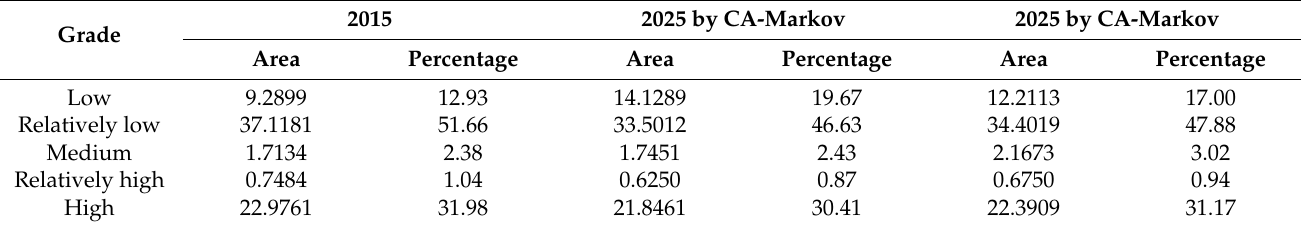
Figure 9. Spatial distribution patterns of habitat quality in 2025 projected by CA-Markov and FLUS. Table 6. Changes in area and percentage of different classes of habitat quality in 2015–2025 (10 4 ha, %).